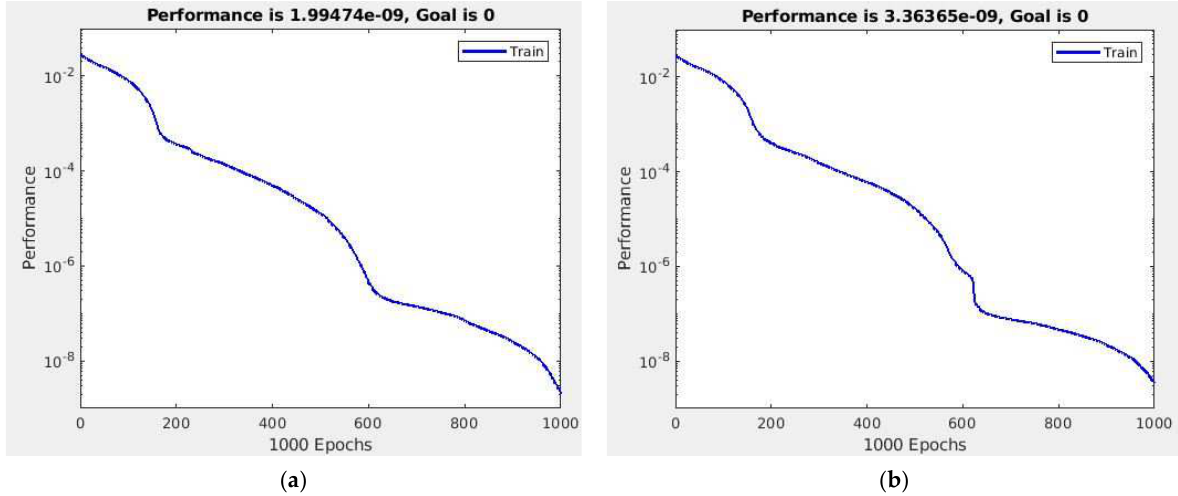
Figure 18. Training convergence curves of RBF-NN: ( a ) 2.7 Gbps data transmission; ( b ) 3.6 Gbps data transmission.